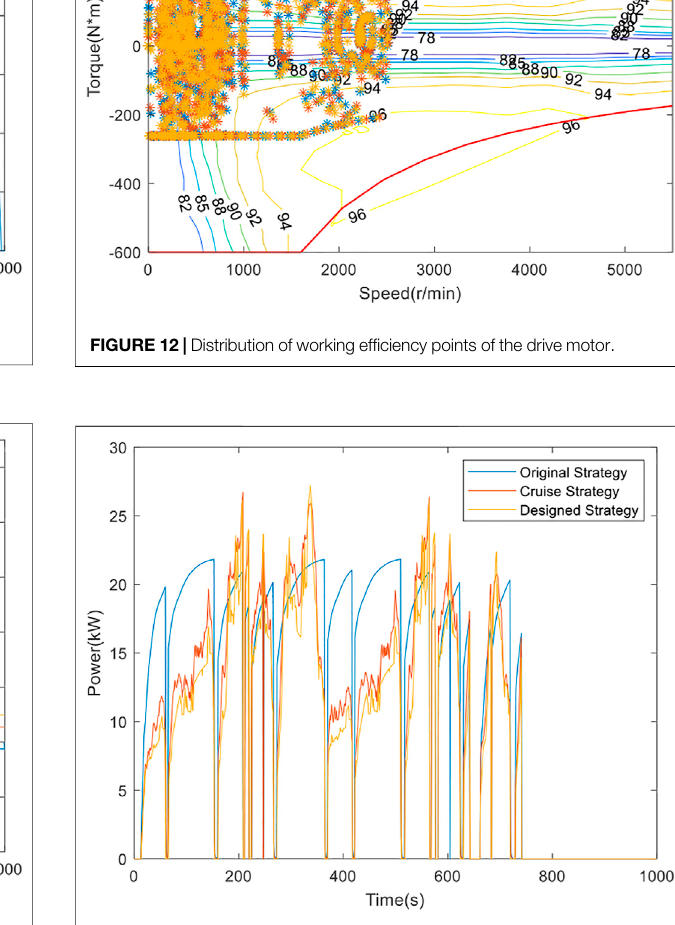
FIGURE 11 | SOC trend changes.